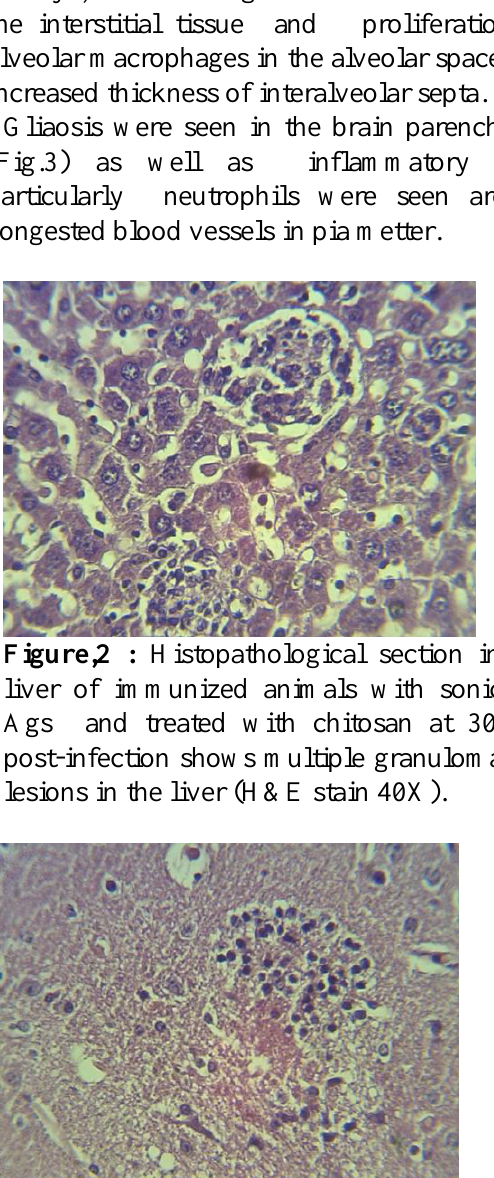
mononuclear cells in capsular region as well